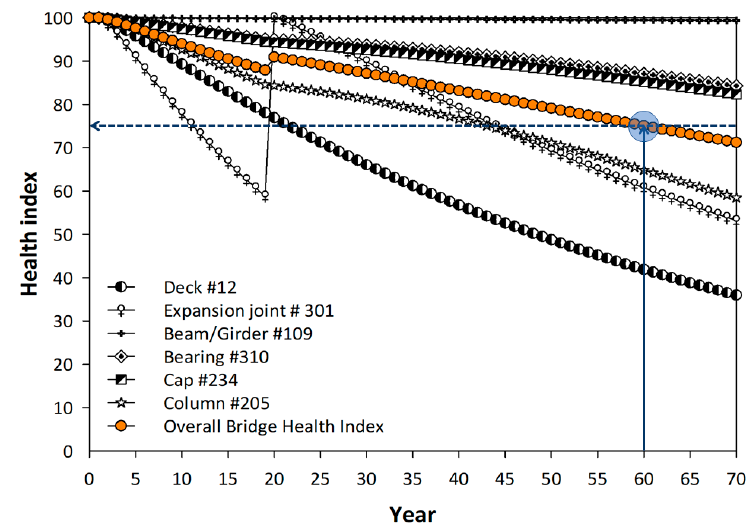
Figure 13. Effect of an Expansion Joint No. 301 Replacement (after applying the Co-Active approach). Figure 13. E ff ect of an Expansion Joint No. 301 Replacement (after applying the Co-Active